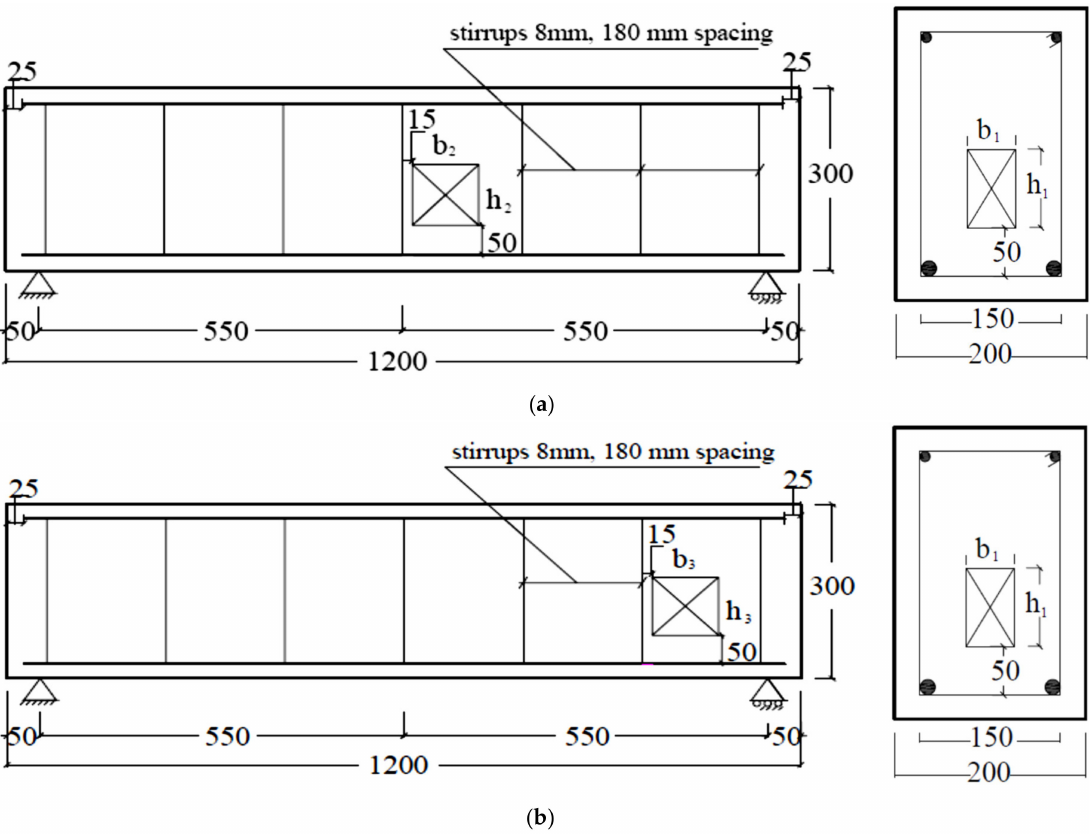
Figure 7. Details for the RC beams with opening in different positions: ( a ) TNCH; ( b ) TNSH (dimensions in